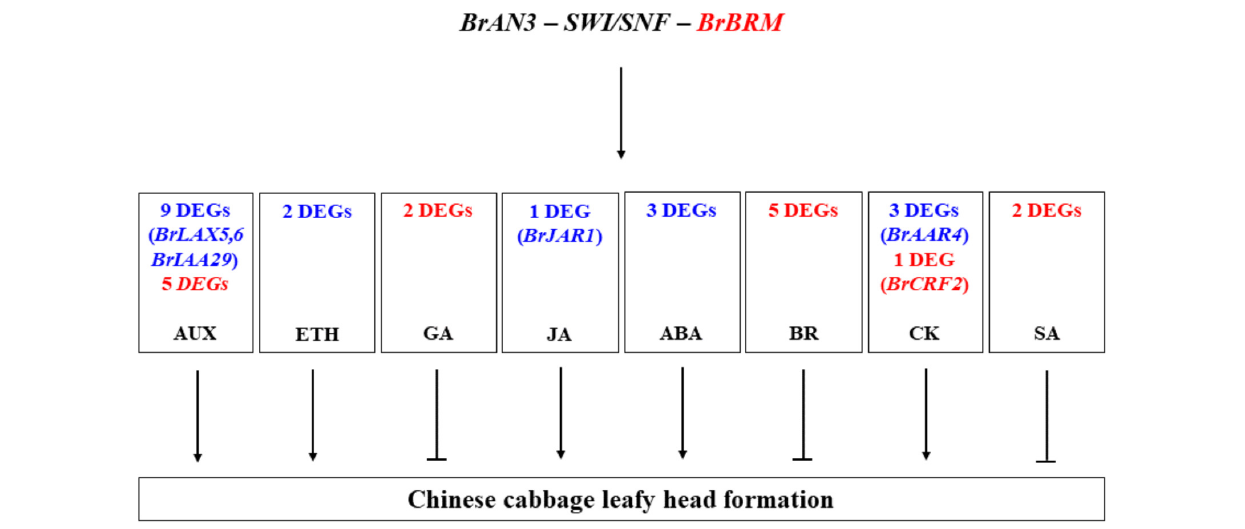
FIGURE 8 | The potential roles of the signaling pathways of auxin (AUX), ethylene (ETH), gibberellin (GA), jasmonic acid (JA), abscisic acid (ABA), brassinosteroid (BR), cytokinine (CK), and salicylic acid (SA) in leafy head formation in Chinese cabbage. Red and blue font colors indicate the significantly induced and decreased DEGs detected by RNA-Seq in the present study. The genes in the parenthesis, which were functionally studied in previous studies, had been identified as the DEGs in the present study. Arrows represent the positive effects while inhibition arrows represents the negative